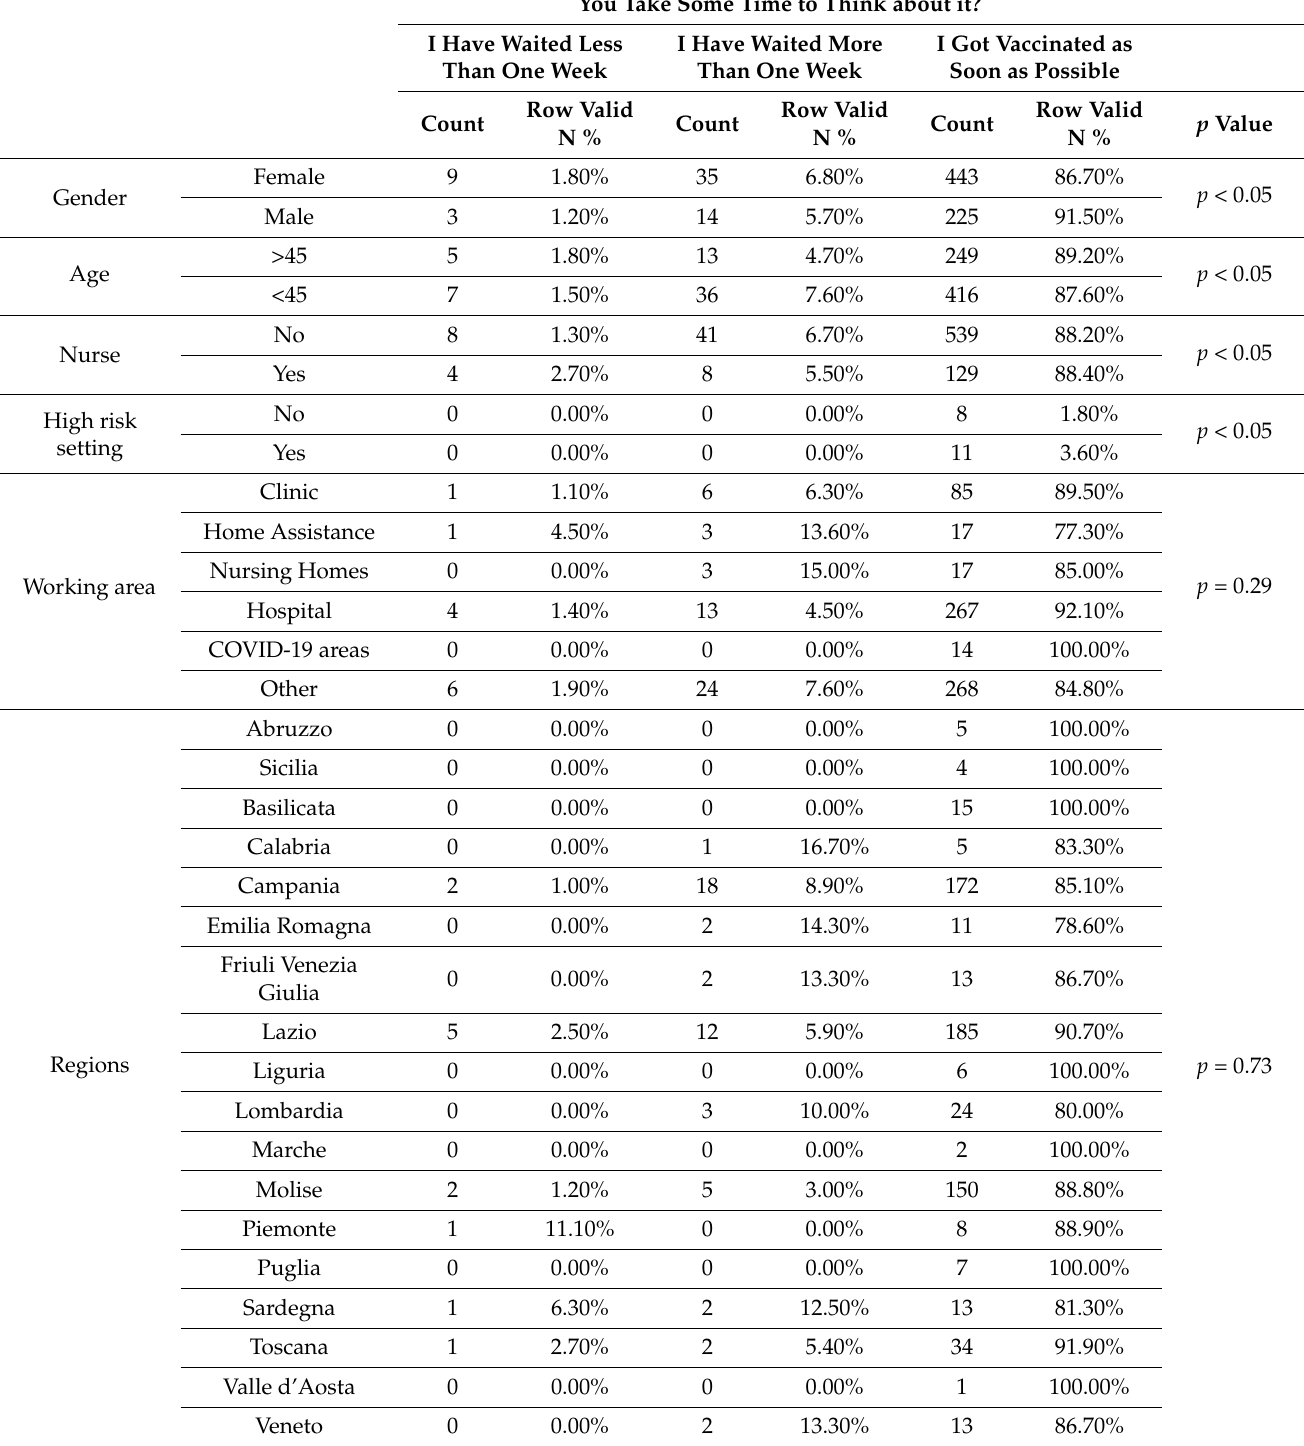
Table 2. Association between different level of vaccine acceptance and demographic/occupational characteristics of the study